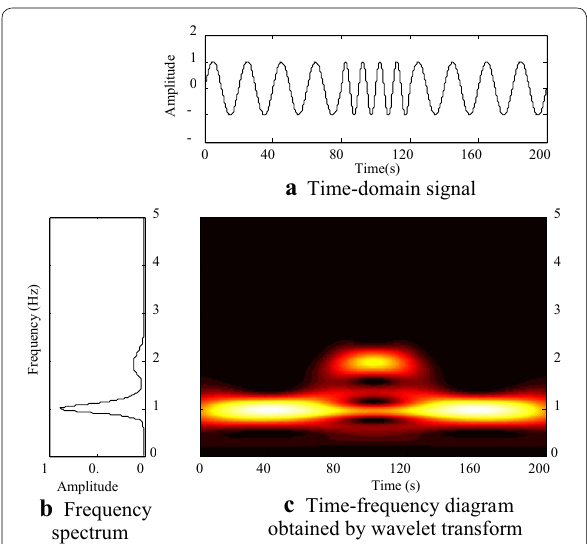
diagram (obtained using a time-frequency joint analysis such as a wavelet transform (Figure 10(c)); and 3D data, including a time-frequency diagram of multiple sensor signals. As shown in Figure 11, the aforementioned sig- nals can be used as the input of 1D DNNs, 2D DNNs, and even 3D DNNs. Figure 12 shows two realization routines (research ideas) based on 1D and 2D DNNs.